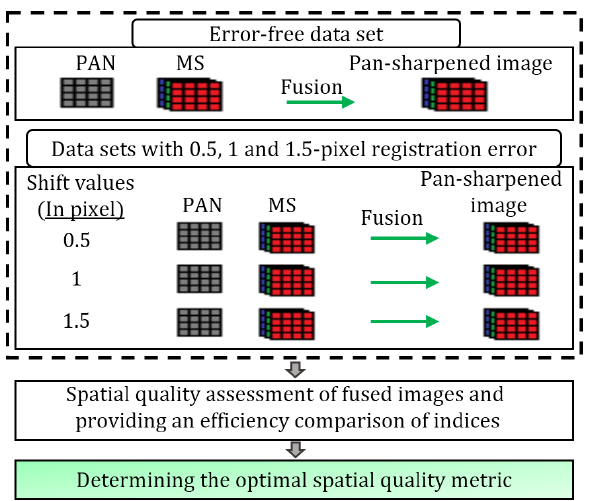
Figure 1. Diagram of the proposed strategy for determination of the optimal spatial indices in image fusion quality assessment.